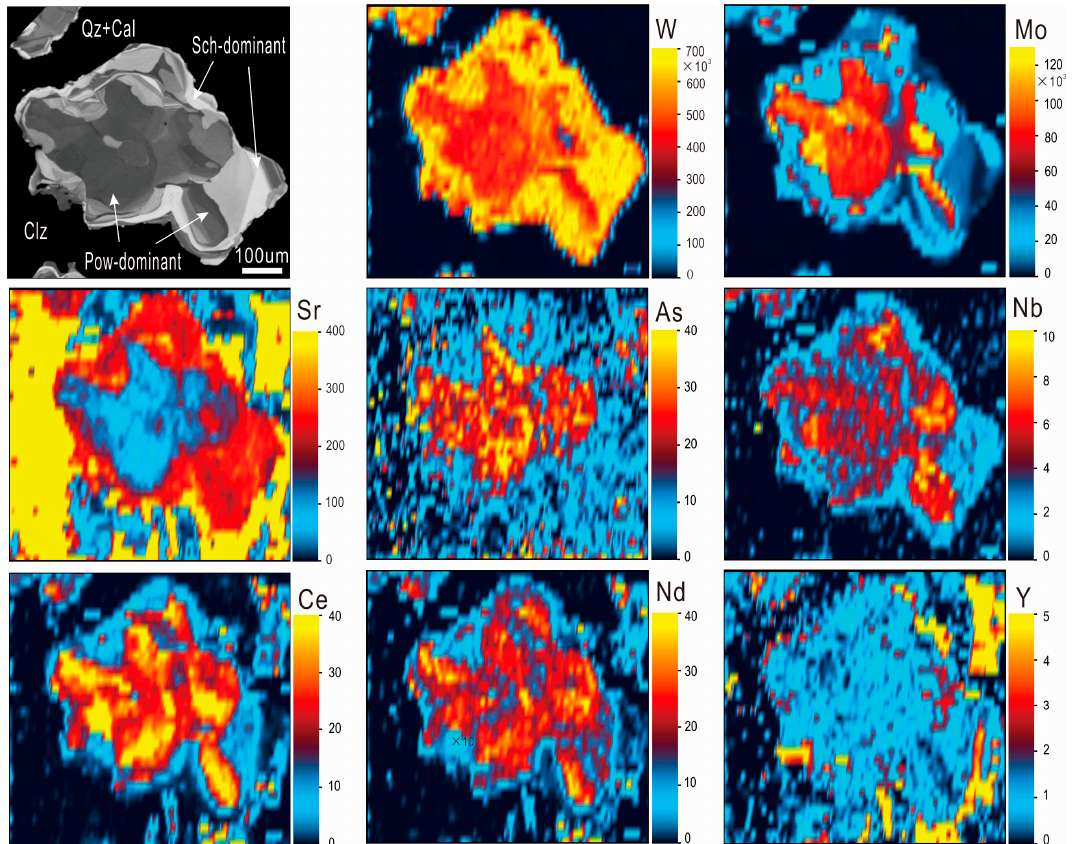
Figure 7. Laser ablation inductively coupled plasma mass spectrometry (LA-ICP-MS) element maps of scheelite-powellite for selected elements. Colour scales in parts-per-million. The image shown upper left is a CL image of the mapped area. Note strong relative enrichment in As, LREE (Ce and Nd are shown), and Nb in powellite (dark on CL image), and relative enrichment in Sr in scheelite. Yttrium shows no correlation with Mo content, but is apparently present at a higher concentration within the Sch-dominant rims. See main text for additional explanation.